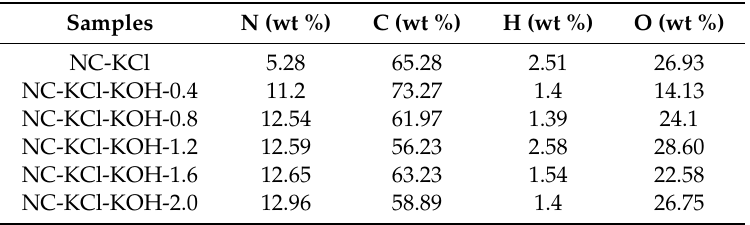
Table 7. The content of N, C, H and O in samples activated by different amount of KOH and 0.75g KCl per 2.20 g resorcinol.